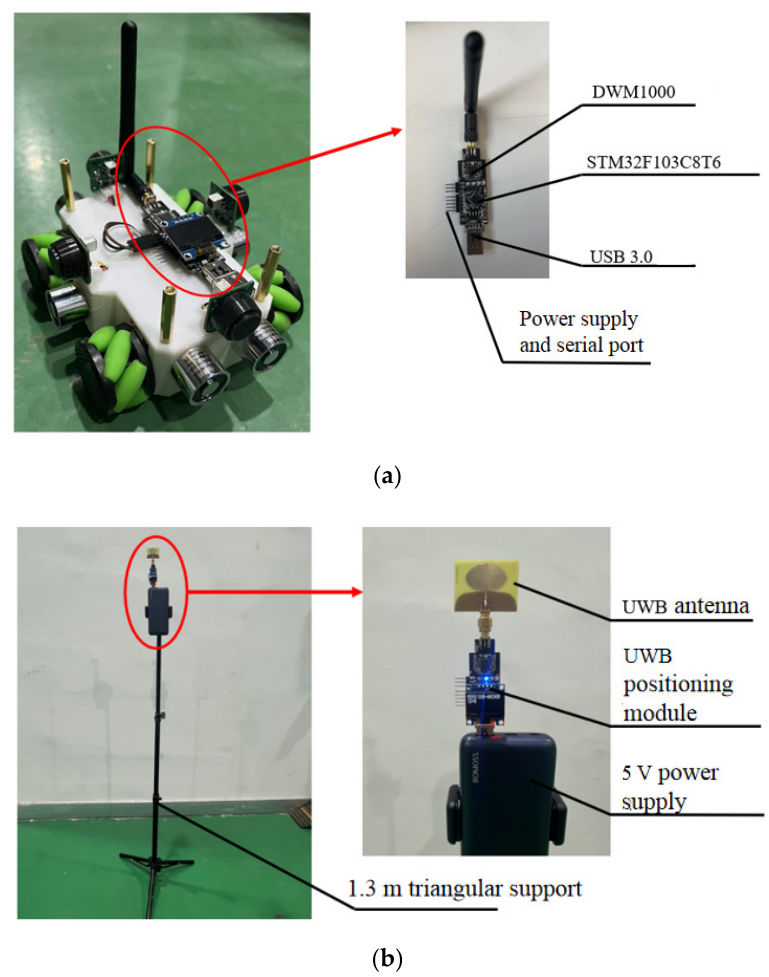
Figure 8. ( a ) Positioning module on modular car; ( b ) Positioning module on base station.